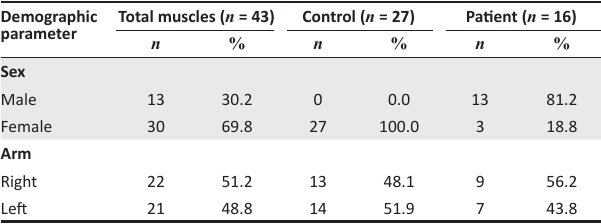
TABLE 4: Specific muscles involved.